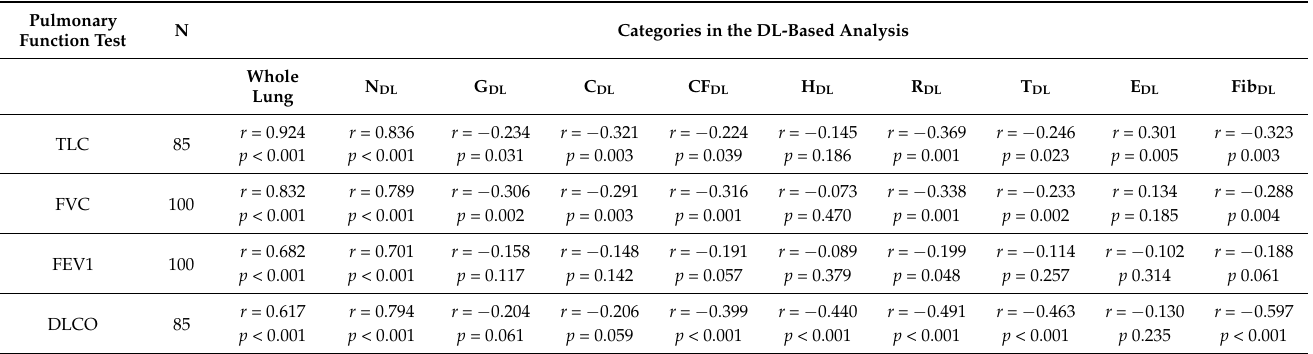
Table 5. Correlations between the DL-based analysis results and pulmonary function test